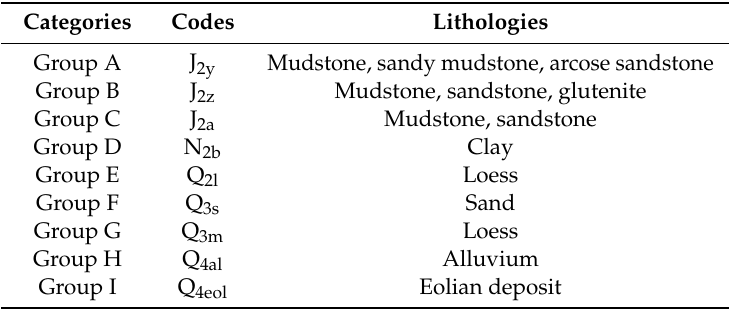
Table 1. Lithology of the study area.